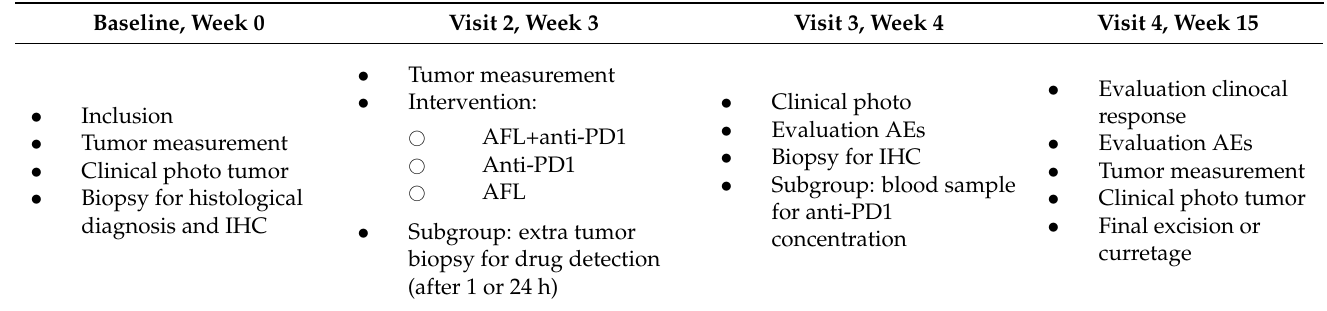
Table 1. Overview of the study